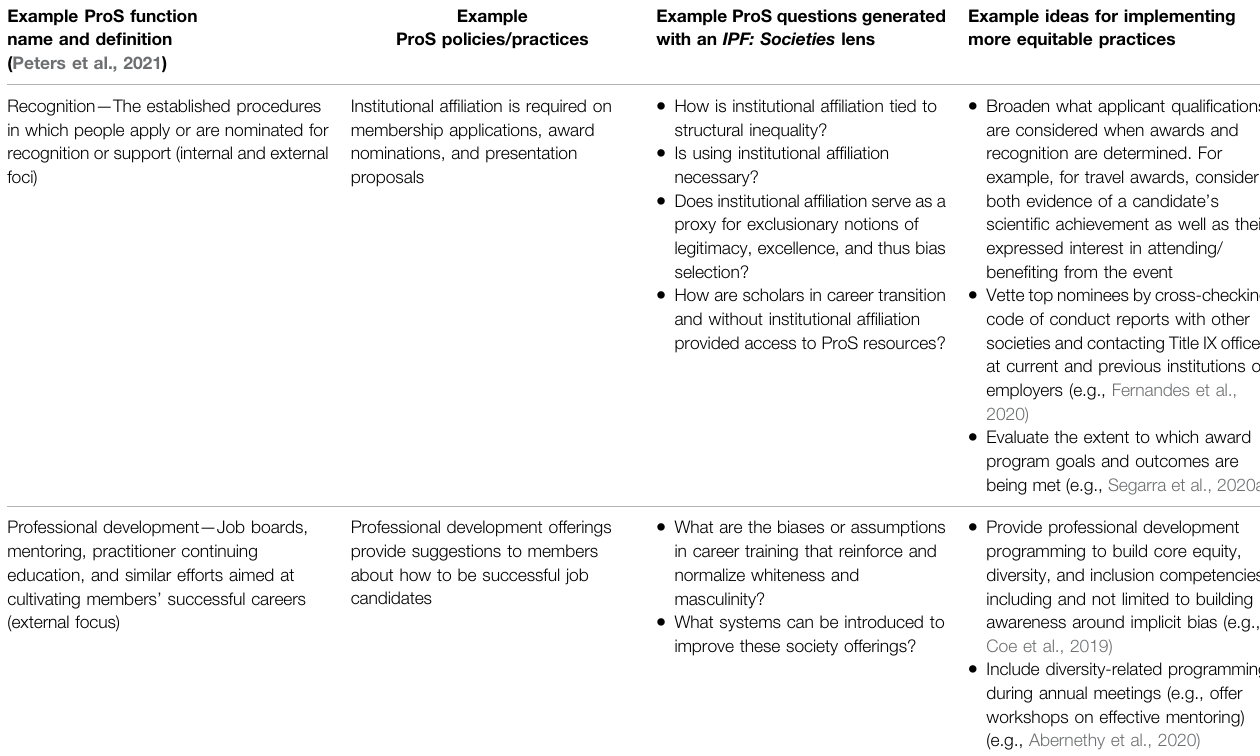
TABLE 1 | ( Continued ) How the IPF: Societies informs practices within fi ve example professional society